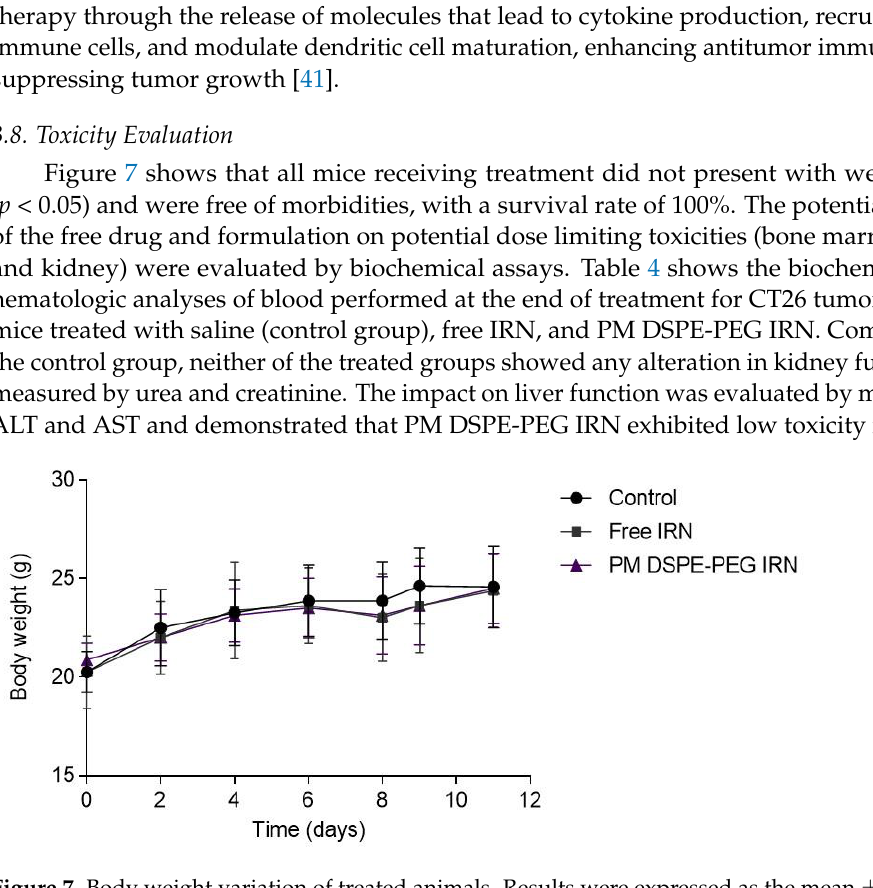
Figure 7. Body weight variation of treated animals. Results were expressed as the mean ± standard deviation. Table 4. Hematological and biochemical parameters of CT26 tumor-bearing BALB/c mice after dif- ferent treatments.